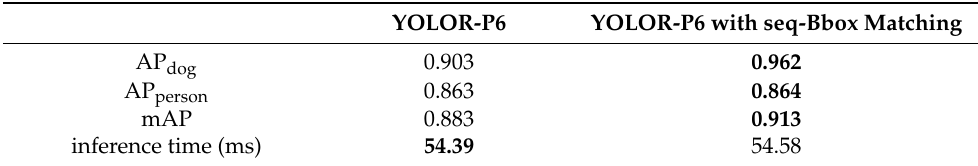
Table 4. Average precision (AP), mean average precision (mAP) and average inference time of YOLOR with and without seq-bBox matching postprocessing.